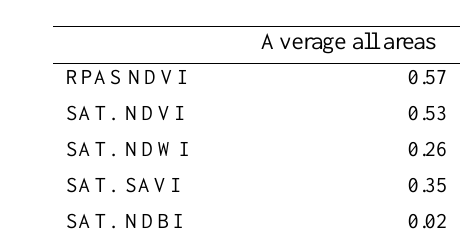
Table 2. Minimum and average values used to set the threshold for the Mowed PP class.